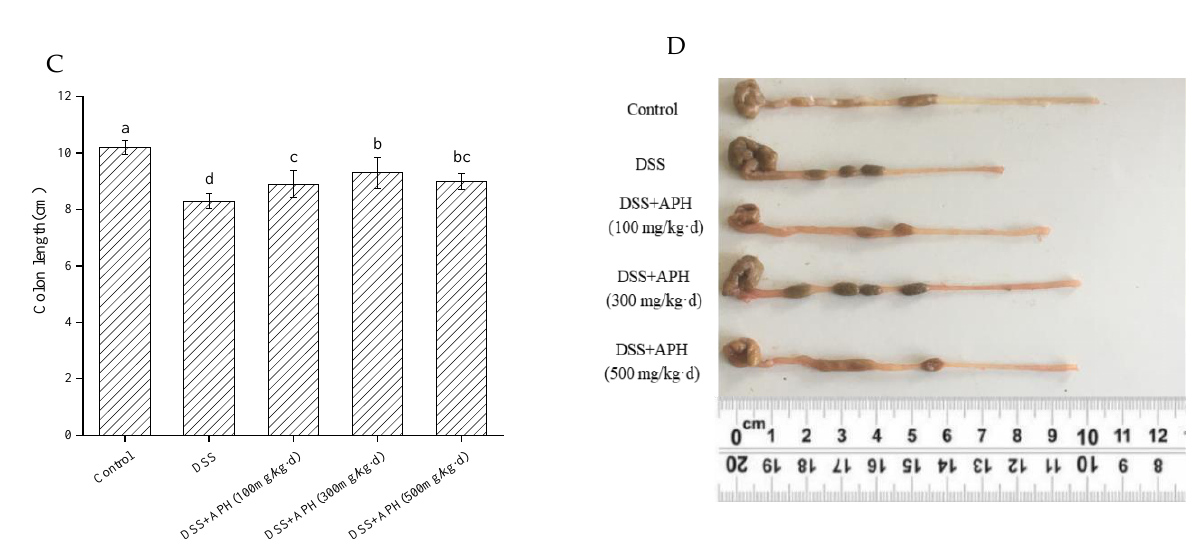
Figure 1. APH ameliorates clinical signs of colitis in mice. ( A ) Changes in body weight; ( B ) DAI scores; ( C , D ) colon length. Data are expressed as mean ± SD ( n = 8). Different letters indicate significant differences ( p < 0.05).